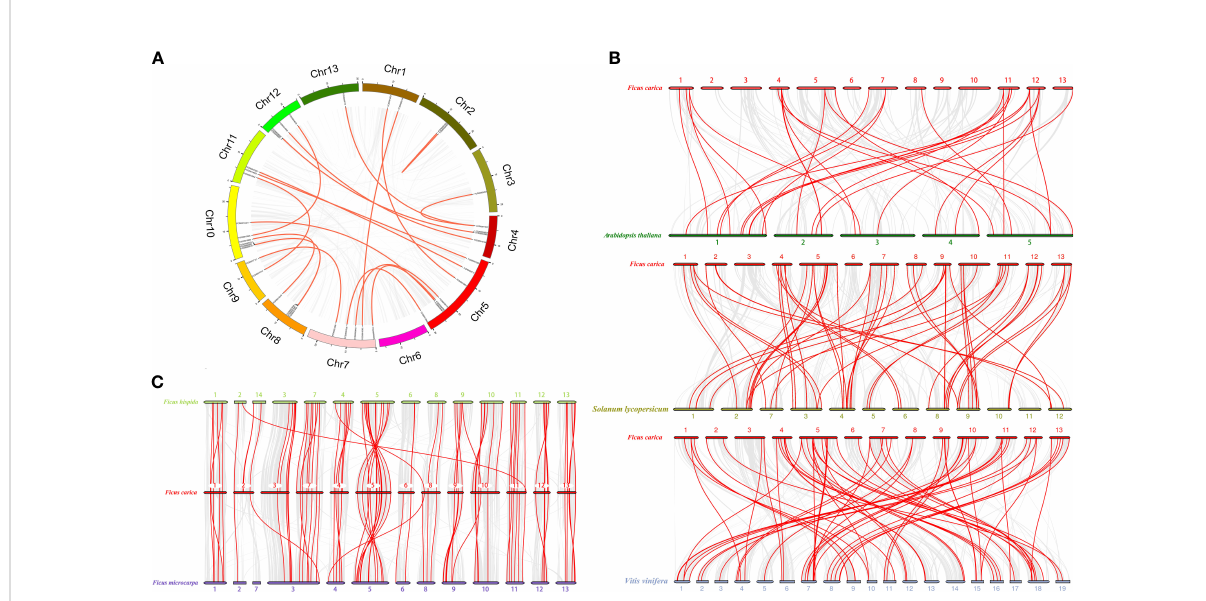
FIGURE 4 Collinearity and synteny analyses of FcAP2/ERF genes. (A) Collinearity of FcAP2/ERF genes. (B) Synteny analysis of AP2/ERF genes in F. carica and three other plant species. (C) Synteny analysis of AP2/ERF genes in three Ficus species ( F. carica , F. hispida , and F. macrocarpa ). Gray lines indicate all syntenic gene pairs within the genomes; red lines indicate syntenic AP2/ERF gene